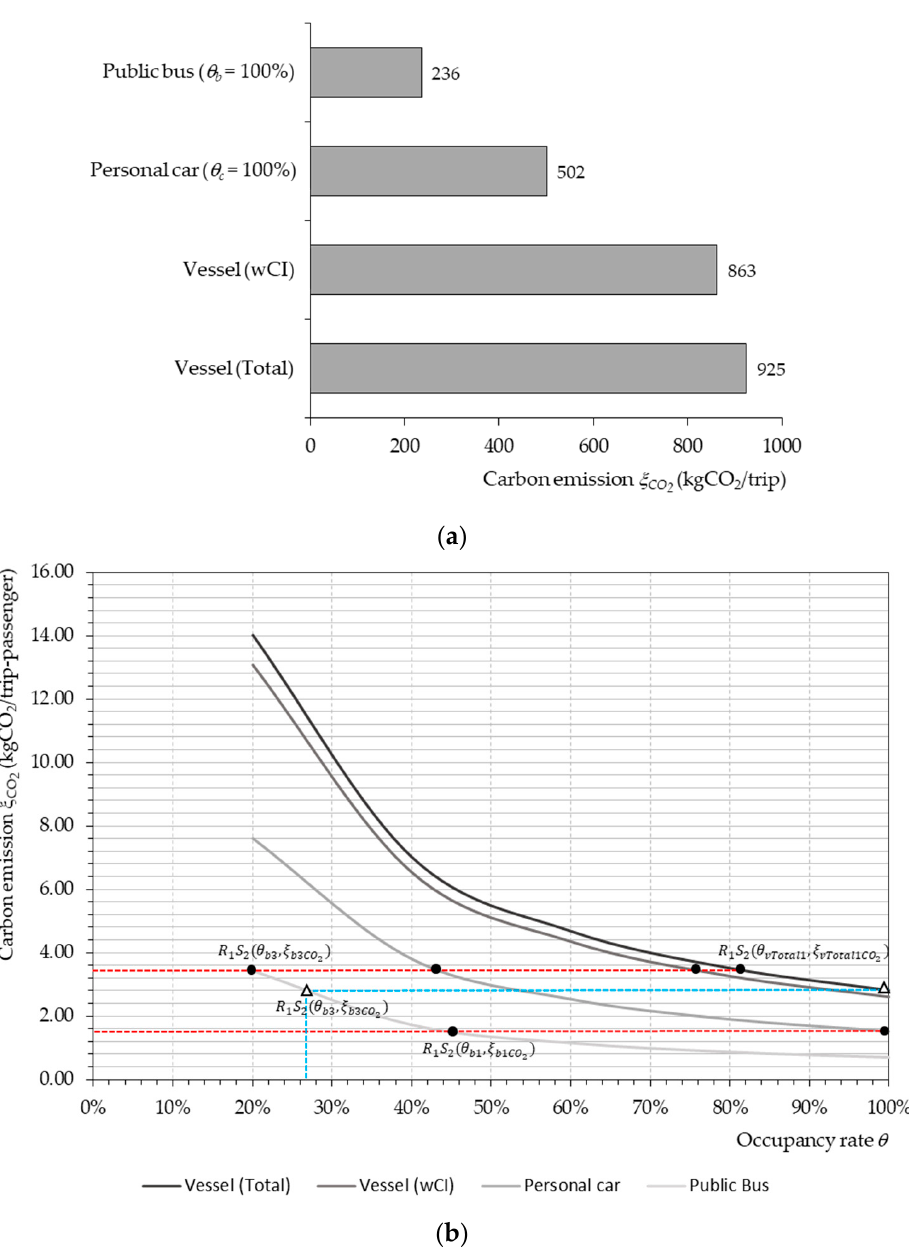
Figure 9. Calculated carbon emissions on the route segment R 1 S 2 : ( a ) total carbon emissions per single trip with respect to each transportation mode and based on the reference capacity of 330 passengers; ( b ) comparison of carbon emissions with respect to the θ for each transportation mode